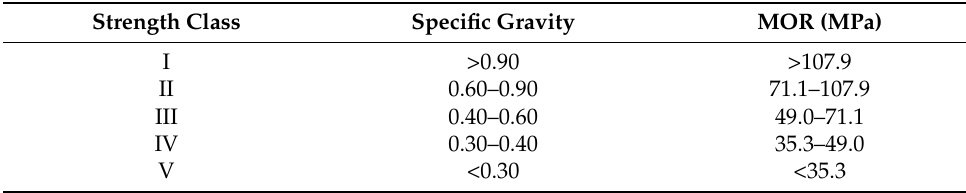
Table 1. Strength classification of Indonesian